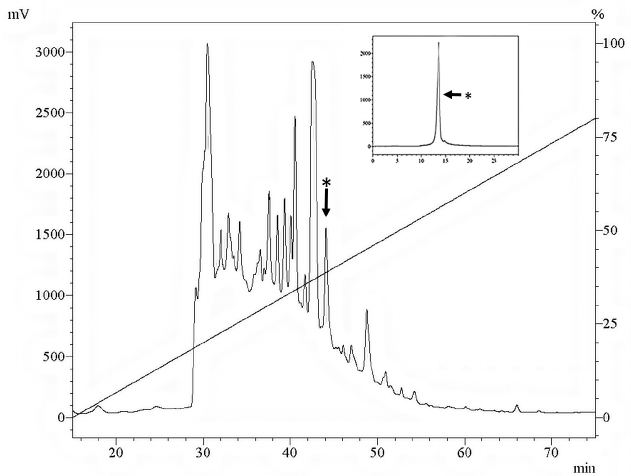
Figure 1. RP-HPLC profile of lyophilized larval ES crude extract at 225 nm eluted on a Jupiter C18 Column (10 mm × 250 mm, 10 µ m; 300 Å), using a 0–80% B linear gradient in 80 min, solvent A: 0.05% TFA / ACN and solvent B: 0.05% TFA / H 2 O at 1.5 mL / min flow rate. Inset: the sarconesin II fraction labelled with an asterisk was chromatographed in the same solvent system on a Jupiter C18 column (4.6 mm × 250 mm, 10 µ m; 300 Å) using a 30–45% B linear gradient in 60